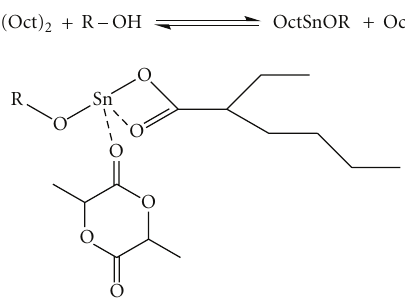
Scheme 12: Tin alkoxide complex initiated polymerization of